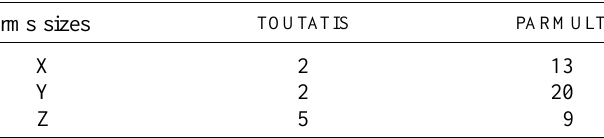
TABLE I. Discrepancies, in percent, between codes and mea- surements for one configuration of RFQ2 tests. rms sizes